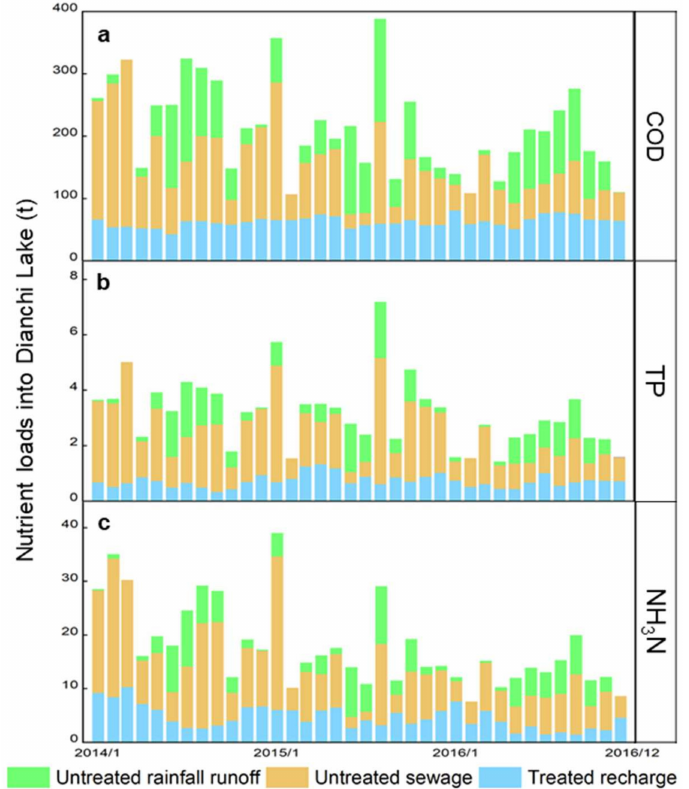
Figure 10. Monthly nutrient loads delineated by each nutrient source: ( a ) COD; ( b ) TP; and ( c ) NH 3